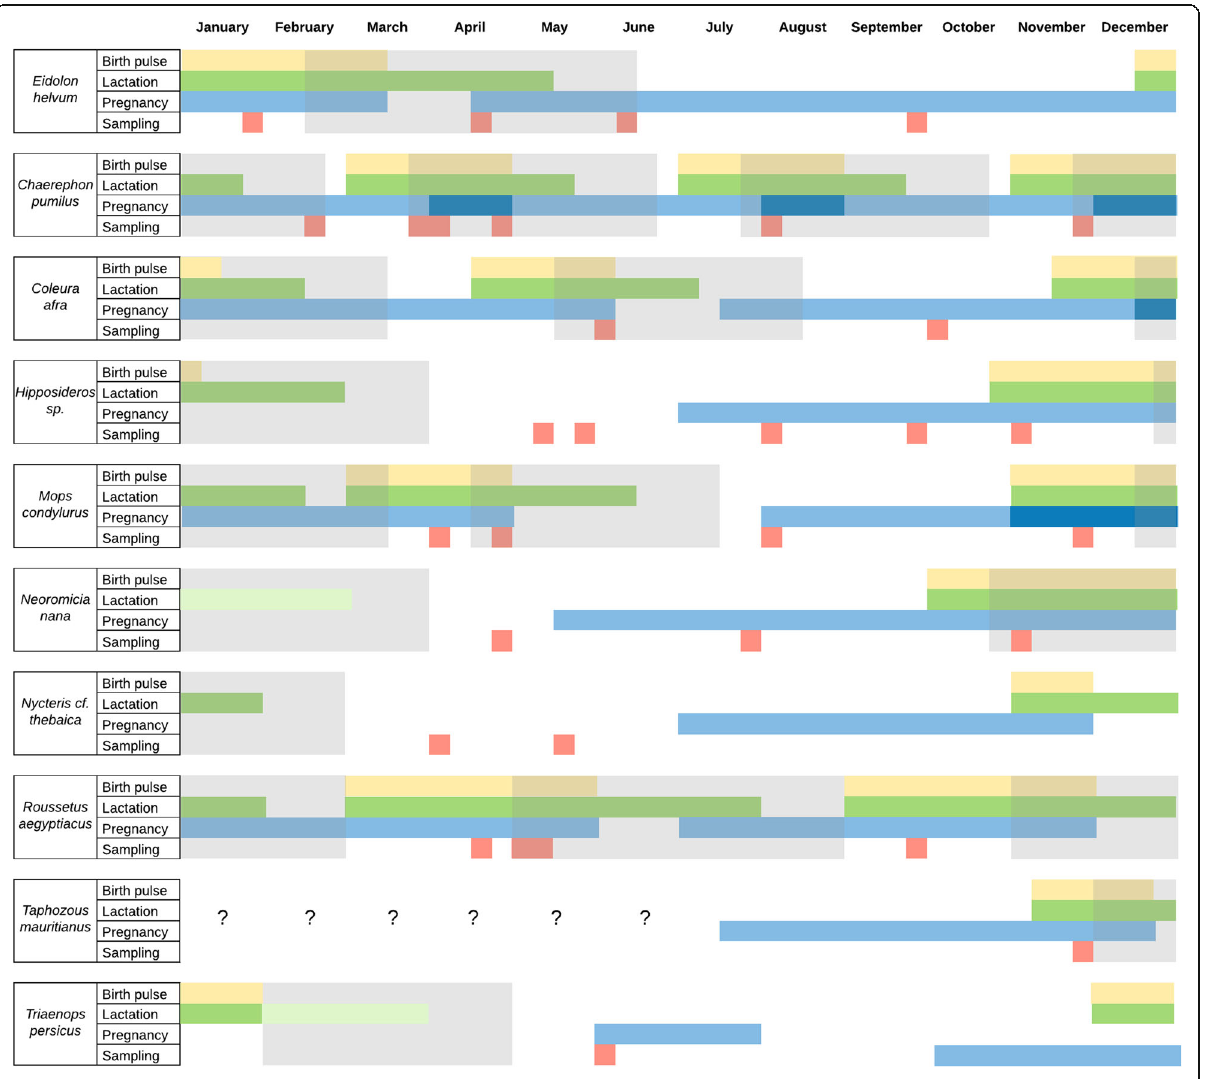
Fig. 2 Summary of the inferred reproductive periods of the bat species sampled. The red squares show the week of a typical year each bat species was sampled. The yellow, green, and blue polygons show the assigned extent of the birth pulse (yellow), lactation (green), and mating- pregnancy periods (blue). The grey polygons represent the inferred “ Recent weaning ” period(s) per bat species. In species with unknown lactation length ( N. nana and T. persicus ), the light green polygons represent the likely overextension of this period not including any other bat in the “ Recent weaning ” period. The question marks show the period we could not infer the corresponding reproductive